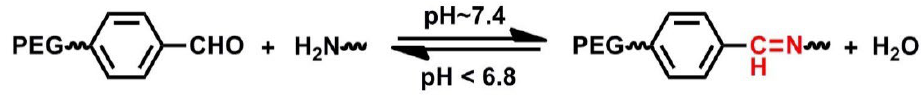
Figure 1. The PEGylation and DePEGylation through the benzoic imine bond.